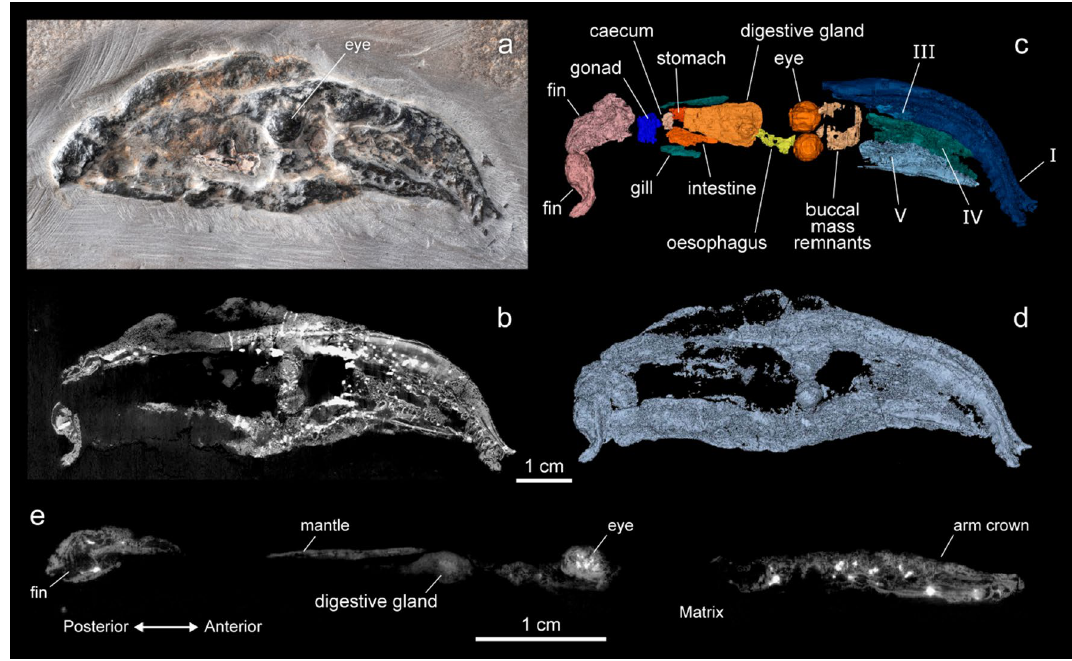
Figure 1. Images and reconstruction of the V. rhodanica holotype (MNHN.B.74247) acquired using PPC- SRµCT (voxel size: 12.64 µm), at the ESRF (Grenoble, France). ( a ) Photograph (P. Loubry, CR2P) of the specimen showing the 3-D preservation of the mineralised soft tissue. ( b ) PPC-SRµCT slice showing the contrast in the grey-scale image used to segment the specimen. This contrast results from the density variation among the various mineralised tissues. ( c ) 3D representation showing the arm crown (arm pair I, III, IV, and V), as well as other presumed internal elements ( d ) 3D reconstruction of the whole specimen ( e ) Sagittal slice showing the profile